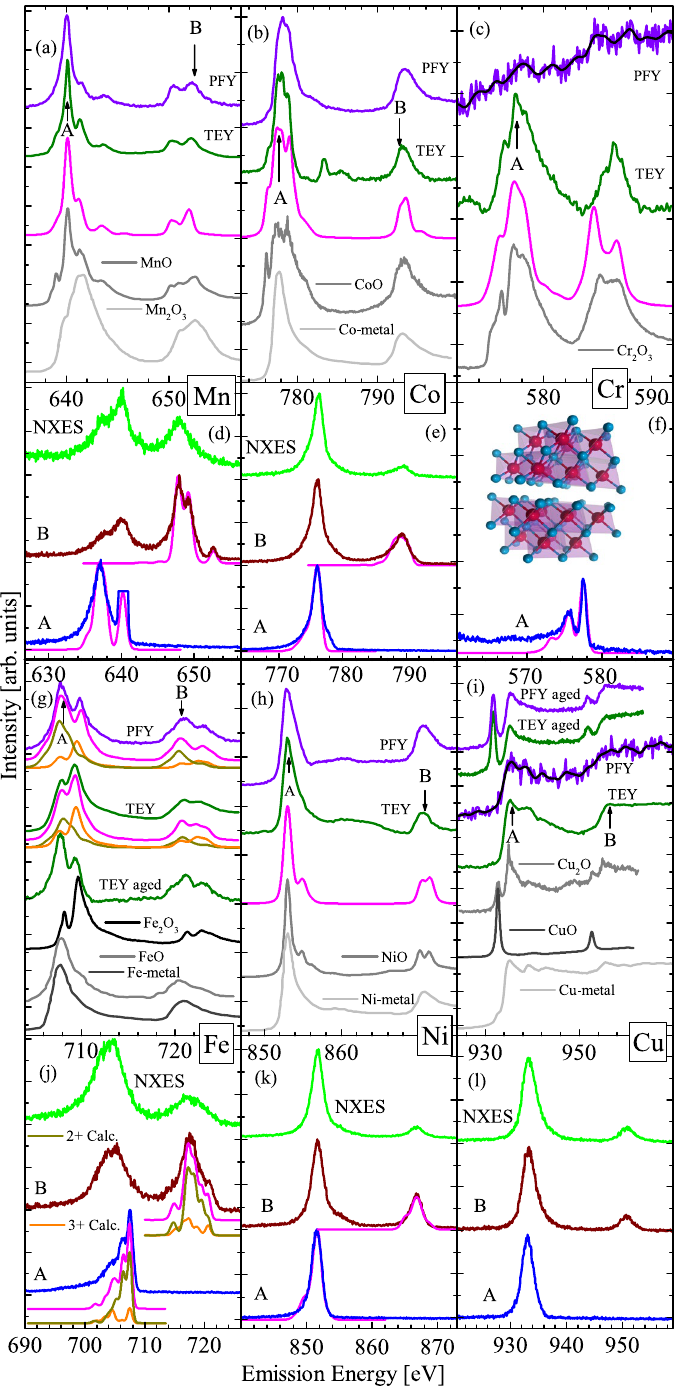
Figure 4. X-ray absorption and emission at the transition metal L -edges along with calculated spectra (pink). The Bi 2 Te 3 : TM XAS spectra are shown in black with standard oxide references in grey for comparison. Panels (a–c) and (g–i) contain the XAS spectra, while beneath each is the corresponding element’s XES spectra in panels d–f and j–l, respectively. In panel (g), the iron calculations are shown in orange and dark yellow, with the linear sum of the two shown in pink. A thorough discussion of each element’s spectra is given separately in the main text. High quality Ni, Co, Fe metal XAS reference spectra were taken from ref.